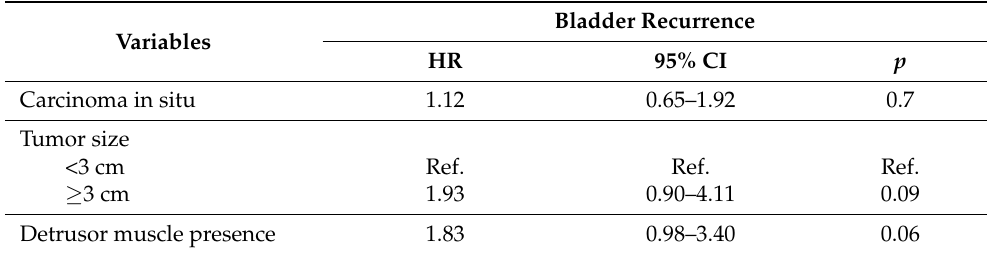
Figure 1. Recurrence-free survival after HIVEC in patients with and without CIS. Table 2. Multivariable results of Cox proportional Hazards Regression to predict bladder recurrence after HIVEC.